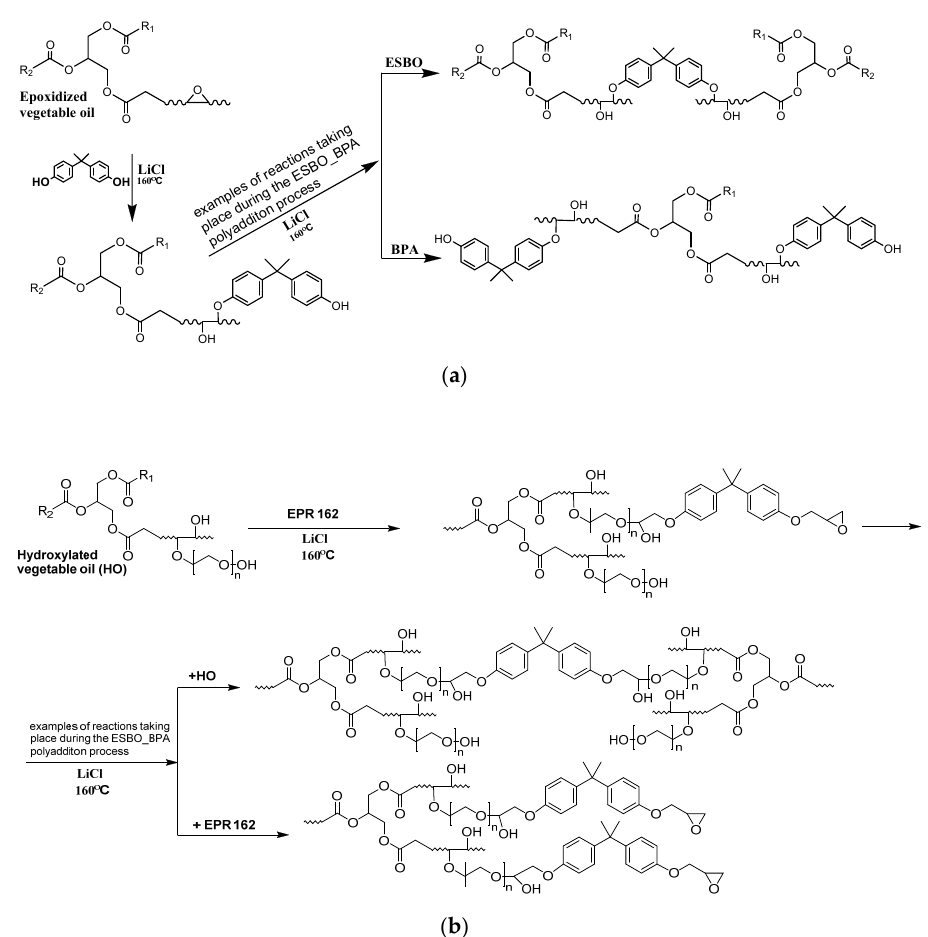
Figure 2. Fusion process of ( a ) epoxidized soybean oil and BPA and ( b ) hydroxyl soybean oil and EPR0162. The ESBO_BPA polyaddition product, characterized by EV = 0.118 mol/100 g, HV = 144 mg KOH/g, M n = 2324 g/mol, and M w = 6363 g/mol, was obtained in a process that took 18 h. In turn, the SMEG_EPR epoxy fusion process of hydroxyl soybean oil and a low-molecular-weight epoxy resin was carried out for 24 h resulting in a product with EV = 0.113 mol/100 g, HV = 160 mg KOH/g, M n = 2267 g/mol, and M w = 19,320 g/mol. Both syntheses were conducted in the presence of LiCl as a catalyst. The application of the cat- alyst was dictated by (1) the promotion of the reaction of phenol groups of bisphenol